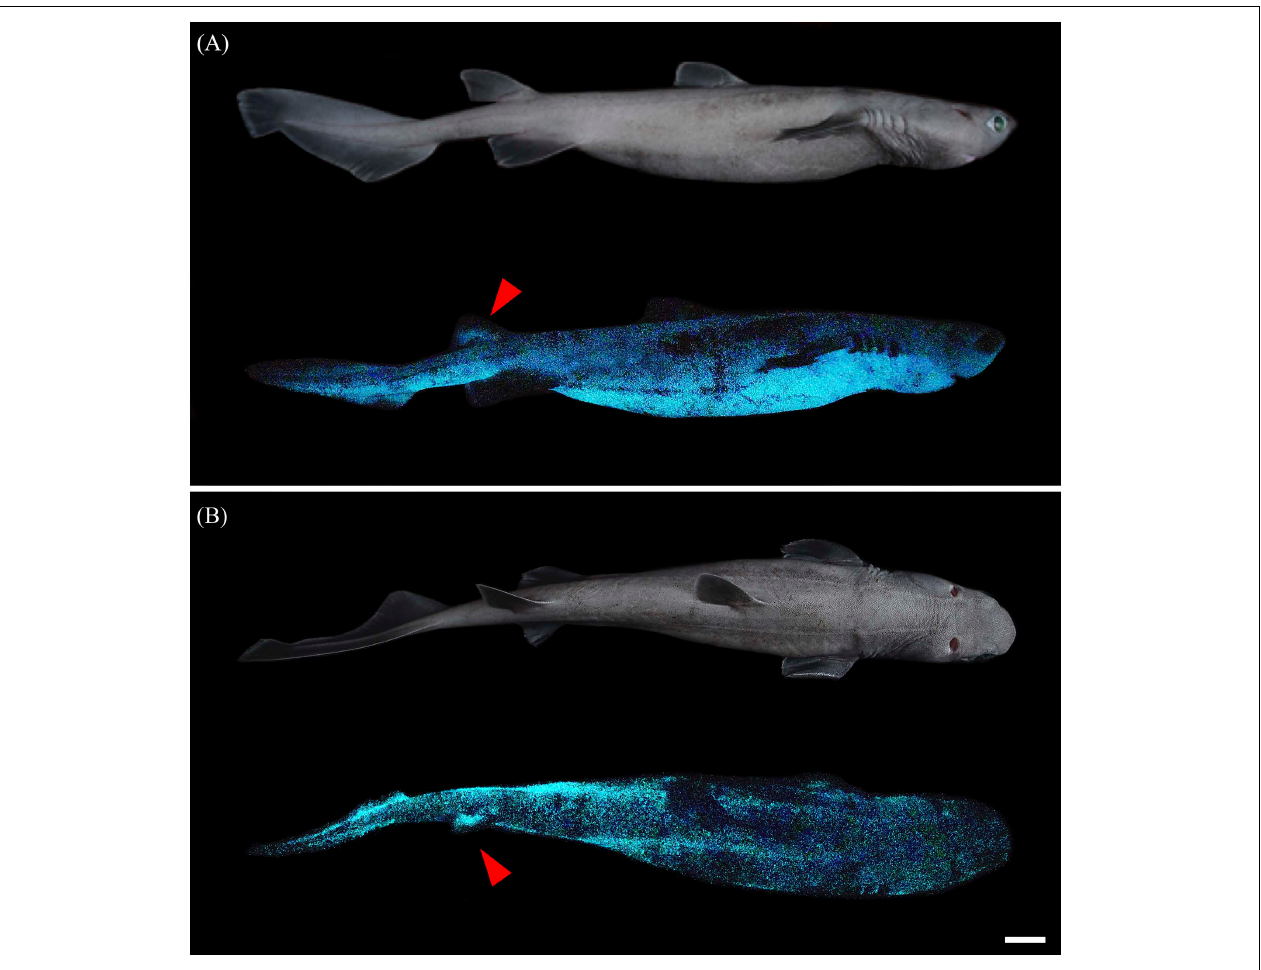
FIGURE 3 | Lateral and dorsal luminescent pattern of Dalatias licha . (A) Lateral daylight view and luminescent pattern highlighting the dorso-ventral luminous pattern. (B) Dorsal daylight view and luminescent pattern. Luminescence of the second dorsal fin is observable on this specimen (red arrowhead). Scale bar: 10 cm.